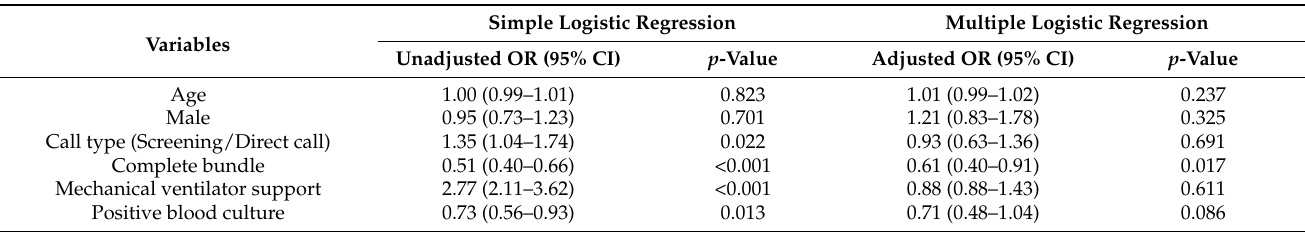
Table 4. Multivariate multiple logistic regression model for 28-day mortality in septic shock